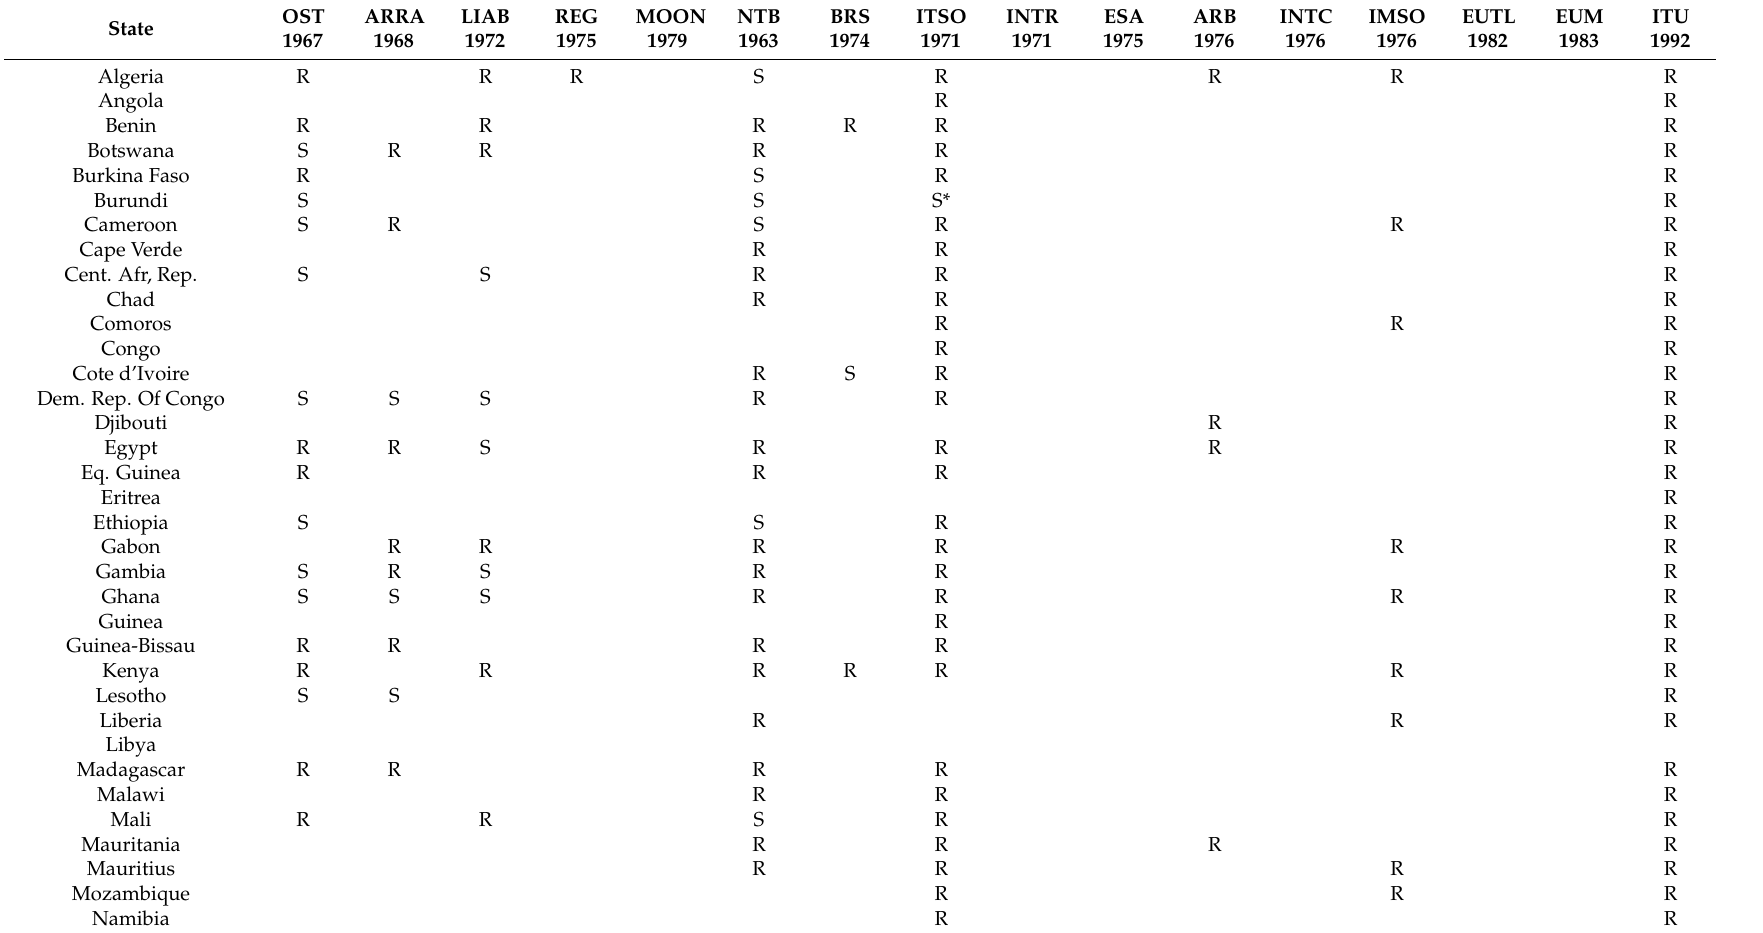
Table 1. African States and the Status of International Agreements on Activities in Outer Space (as at 1 January